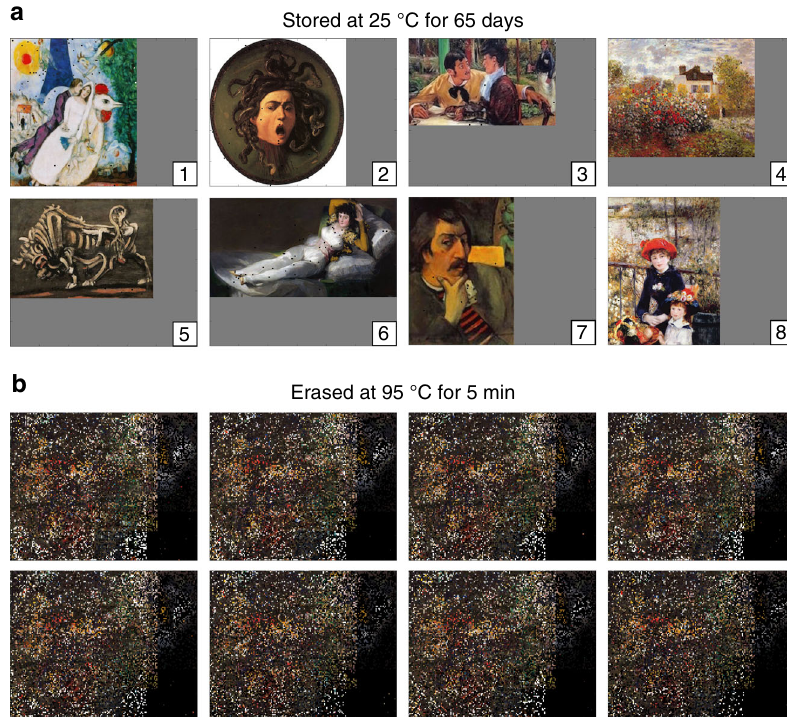
Fig. 4 Demonstration of information storage and erasure on eight separate information solutions. The artworks used are low-resolution images freely available for reuse under the terms of a Creative Commons license or that are marked as being in the Public Domain. a Reconstructed images from NGS reads after the information solutions were stored at 25 °C for 65 days. The bounding box here has dimensions of 320 pixels (horizontal) by 240 pixels (vertical); gray pixels indicate potential addresses outside of each image. b Reconstructed images from NGS reads after the information solutions were erased by incubating at 95 °C for 5